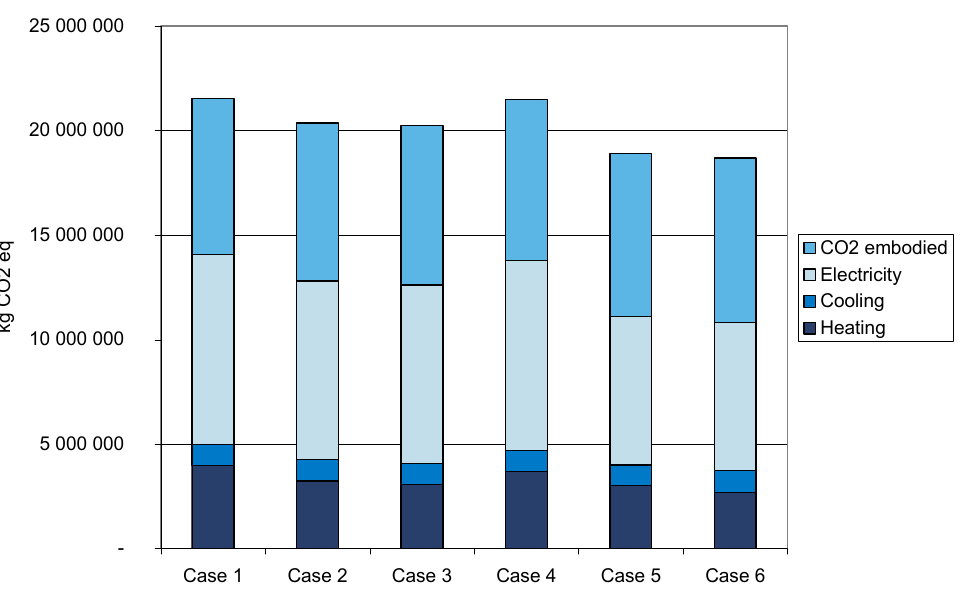
Figure 3. The share of each energy consumption and embodied CO